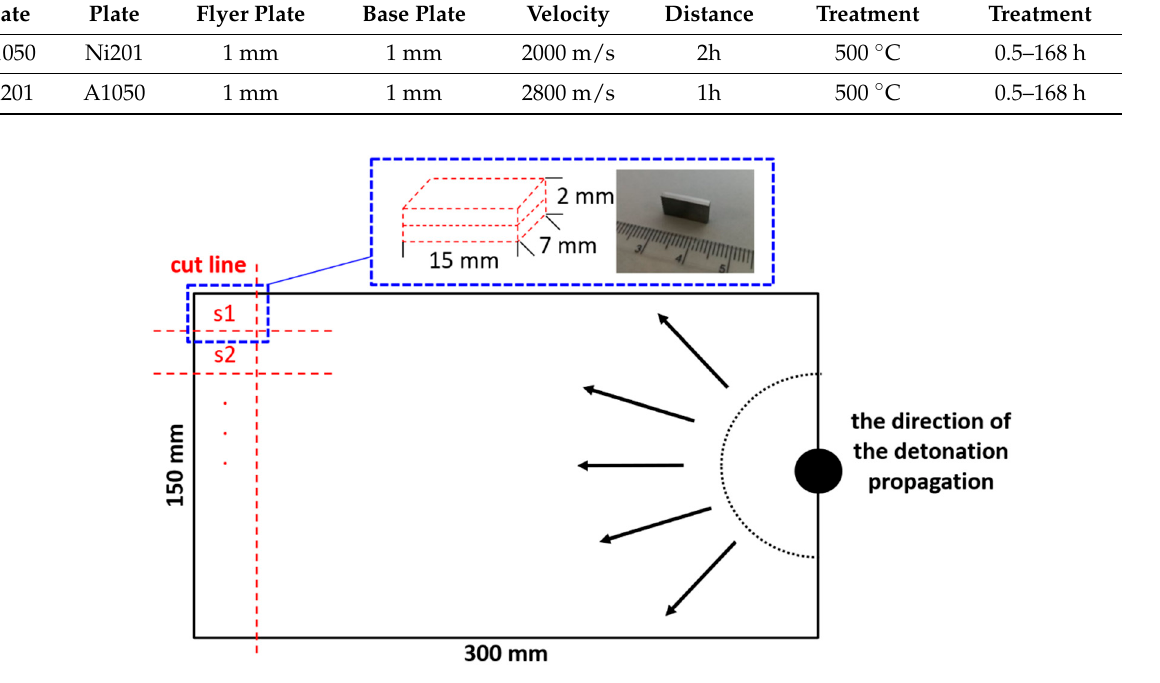
Figure 2. Schematic representation of sample cutting with respect to the direction of the detona- tion propagation.